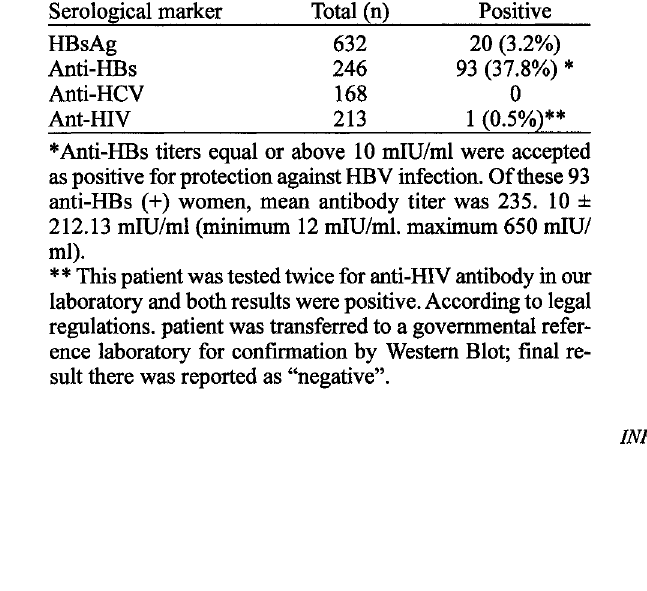
Table 1: HBV, HCV, and HIV seropositivity among 644 preg- nant women